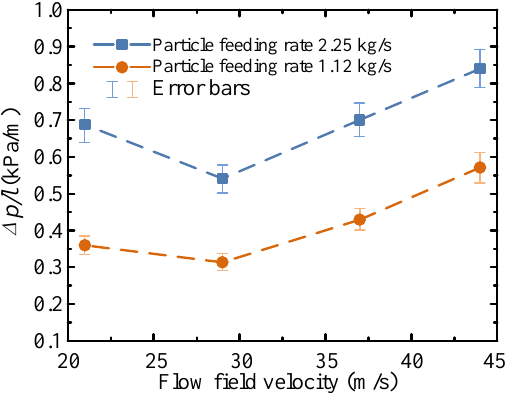
Figure 7. Relationship between pressure drop and flow field velocity.